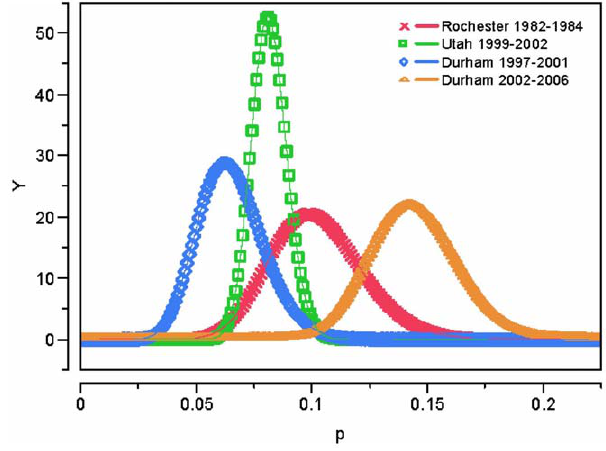
Figure 2. Bayesian Analysis of SBIs among FWLS Infants, 1997– 2001 and 2002–2006. The graph represents the probability of SBI based on data from the early and later periods of this study compared with the Rochester data as well as data on FWLS infants from Utah [5,15]. The probability curve from the data from the later period centers at approximately 14.4% whereas the other three curves all overlap between 5–10% probabilities.